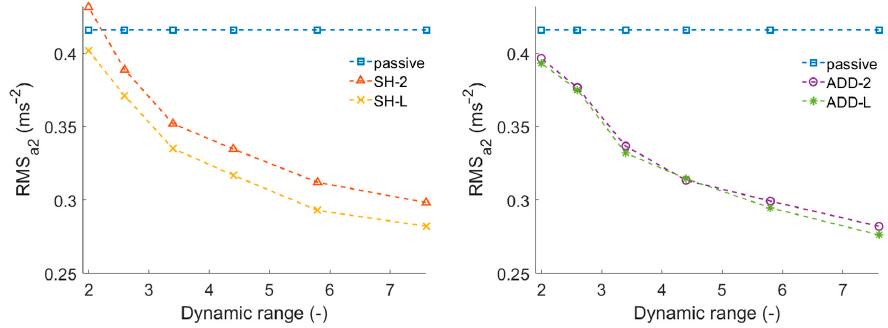
Figure 10. Damper dynamic range DR effect for passive mode, SH-2 and SH-L algorithms ( left ) and for passive mode, ADD-2 and ADD-L algorithms ( right ), HILS results.